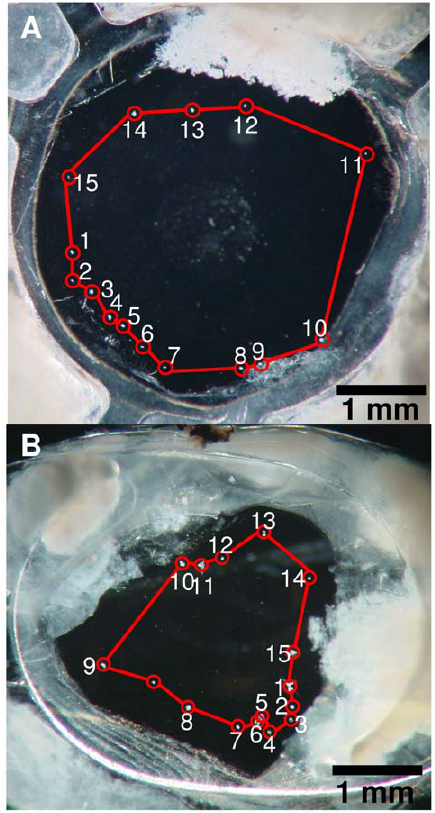
Figure 2. Dark field images of the IOLs acquired with the macroscope setup. Dark regions represent low scattering and light areas represent high scattering. In both images the laser pits and cracks are demarcated. a) IOL with 15 damaged areas with a circumference of approximately 3.5 mm; and b) IOL also with 15 damaged areas, but a circumference of 2–2.5 mm.